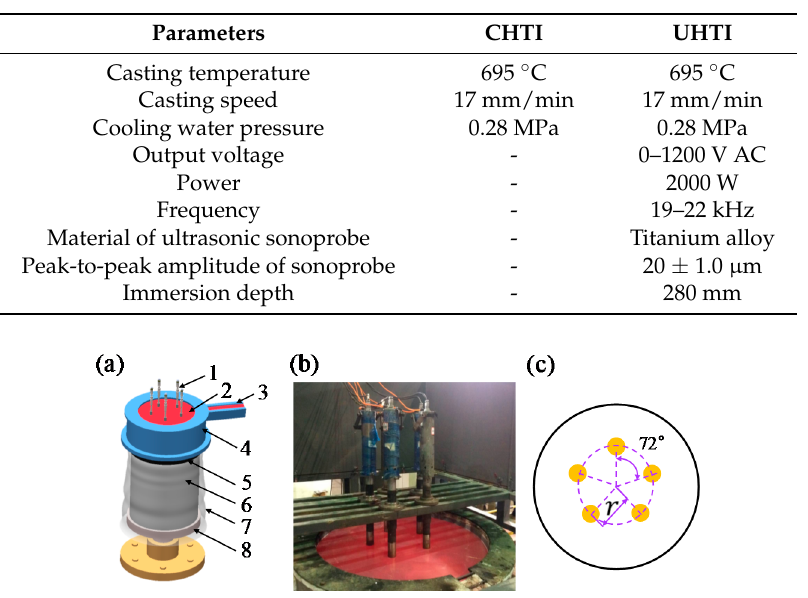
Table 2. Parameters used for the large-scale Al alloy casting.